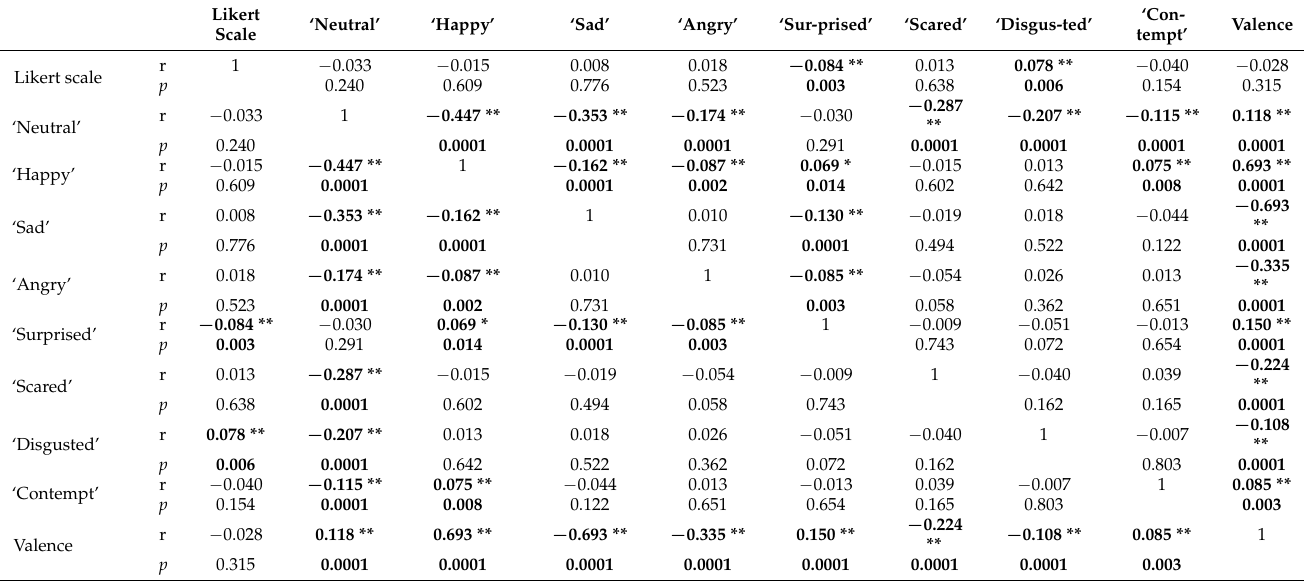
Table 3. Pearson correlations between the emotion’s intensity induced in persons, and the Likert scale